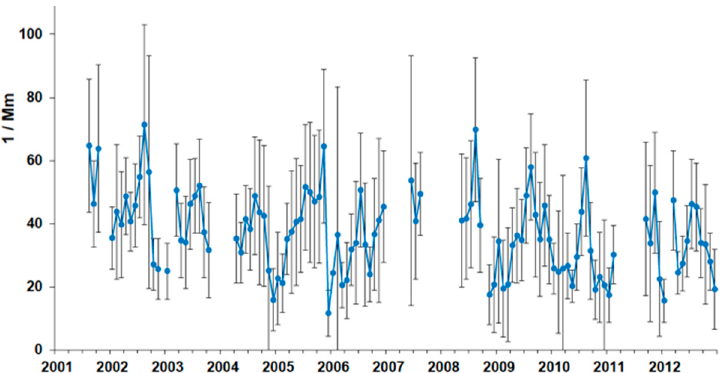
Figure 14. Aerosol scattering based on wet nephelometer measurements at Finokalia indicate a declining trend since 2001. Standard deviation shown as light grey bars. Data from [70].